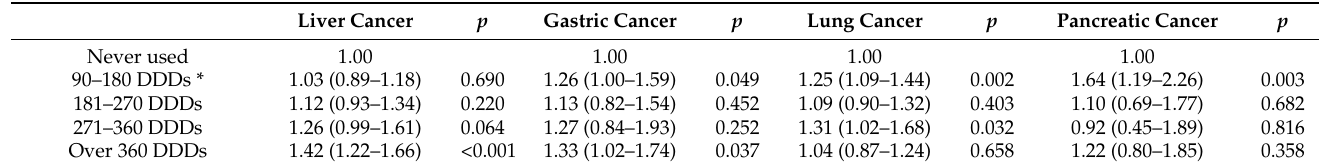
Figure 4. Cumulative incidences of liver cancer for different prescription durations after adjustment for competing risks. Abbreviations: DDDs, defined daily doses. Table 3. Estimates for the association between ranitidine use duration and cancer risk compared with non-ranitidine use by multivariate Cox proportional hazards regression.